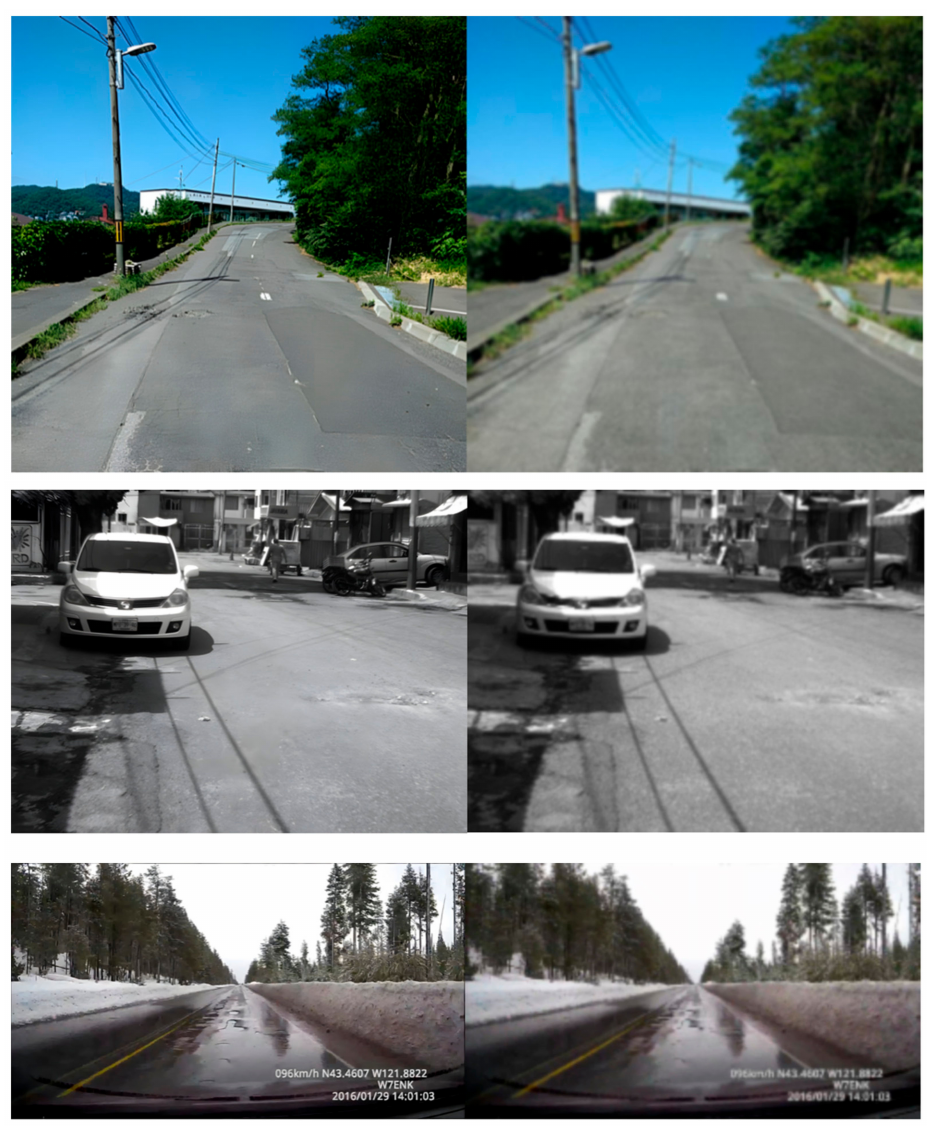
Figure 4. On the left is the SR generated by ESRGAN (4 × scale) compared with the LR image on the right. It can be observed that the SR images provide more feature representation of the objects on scene than the LR